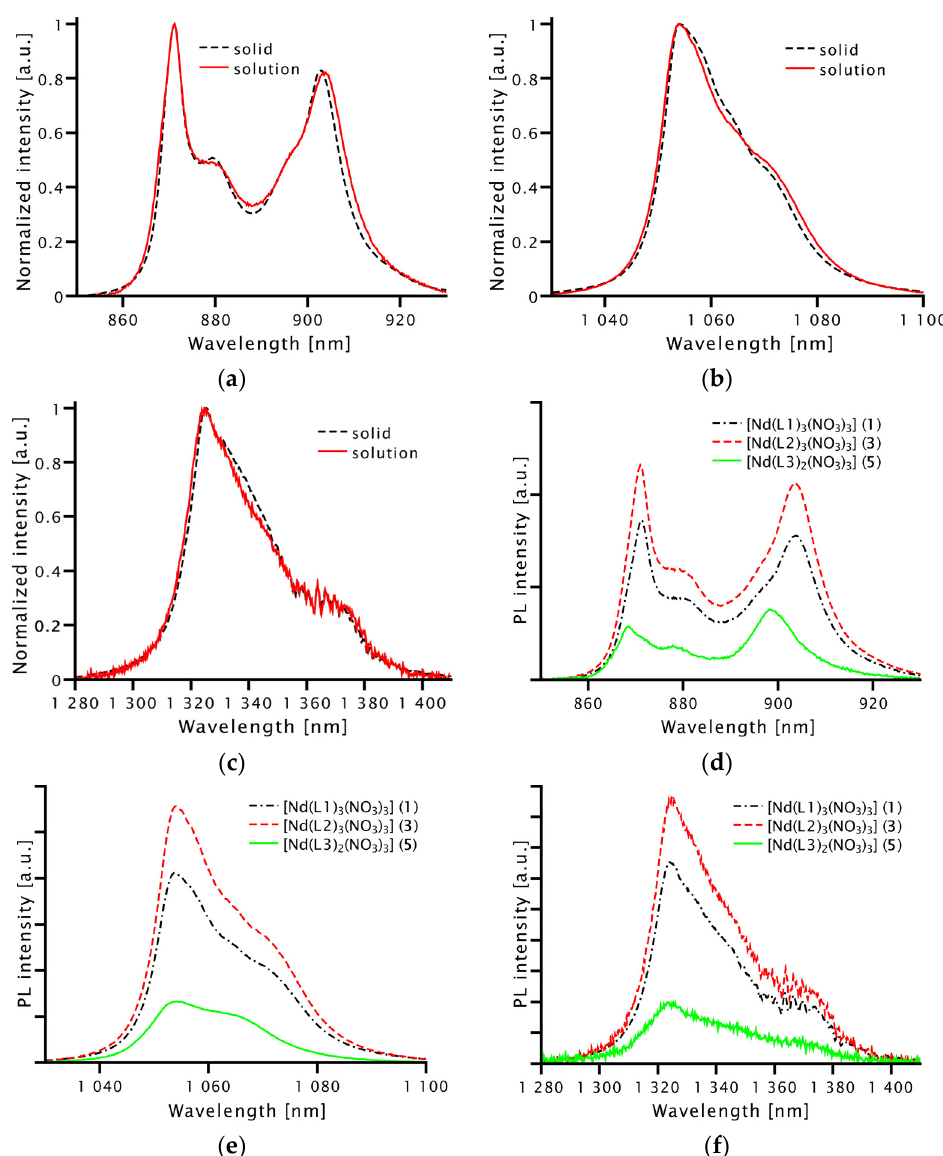
Figure 3. The normalized emission spectra of complex [Nd( L2 ) 3 (NO 3 ) 3 ] ( 3 ) obtained from amorphous bulk material (dashed line) and a solution in dry dichloromethane (DCM) (solid line, c = 4 × 10 − 3 mol/L) related to the transition from 4 F 3/2 to 4 I 9/2 ( a ), 4 I 11/2 ( b ) and 4 I 13/2 ( c ). RT photoluminescence (PL) spectra of [Nd( L1 ) 3 (NO 3 ) 3 ] ( 1 ) (dot-dashed line), [Nd( L2 ) 3 (NO 3 ) 3 ] ( 3 ) (dashed line), and [Nd( L3 ) 2 (NO 3 ) 3 ] ( 5 ) (solid line) in dry DCM (c = 4 × 10 − 3 mol/L) of 4 F 3/2 → 4 I 9/2 ( d ), 4 F 3/2 → 4 I 11/2 ( e ), and 4 F 3/2 → 4 I 13/2 ( f ) transition. For data acquisition, laser power and excitation duration were kept constant. The spiky signal of the 4 F 3/2 → 4 I 13/2 transition ( c , f ) between 1350 nm and 1380 nm is related to setup noise.